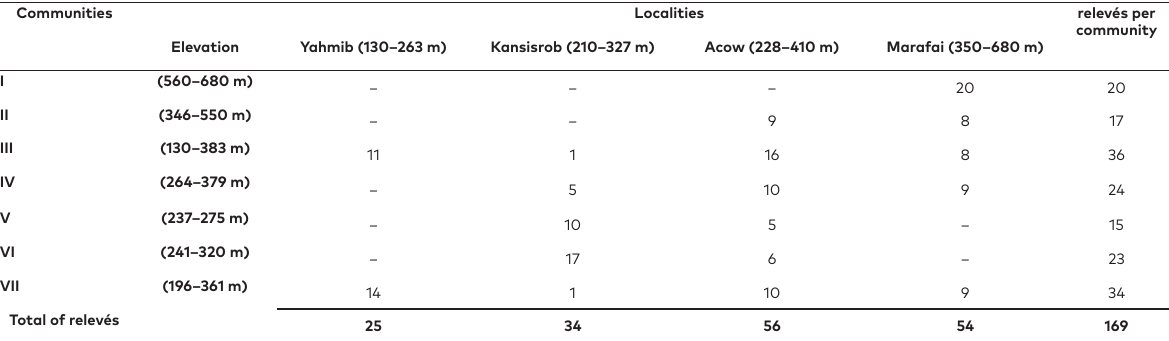
Table 2. Distribution of relevés, communities in the studied wadis, and the elevational gradients of the studied wadis and the seven communities